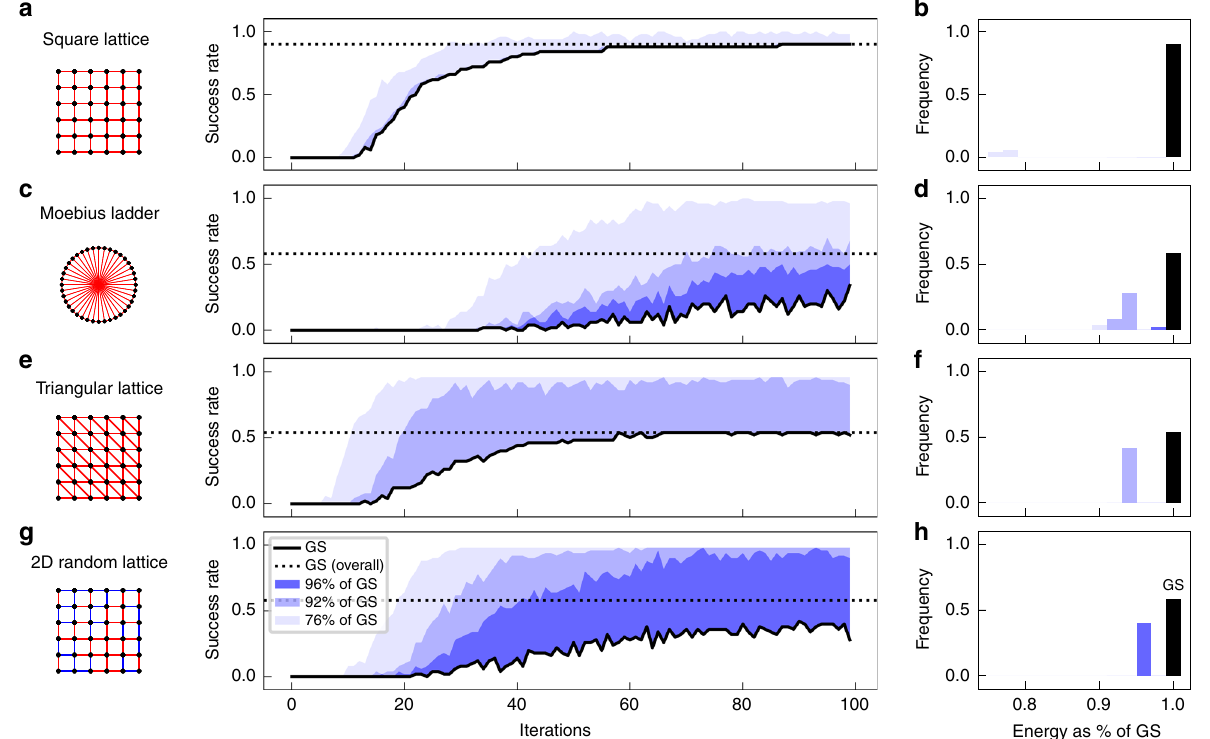
Fig. 4 Time evolution of success rate and energy distribution for various frustrated graphs. Time evolution of the success rate in 50 independent trials to reach the ground state (black line) and 96%, 92%, and 72% of the ground state energy (indicated by shades of blue) as well as the respective histogram of the minimum energies for various graphs with N = 100 spins. Investigated graphs are the square lattice ( a ) and ( b ) (parameters used: α = 0.25, β = 0.29), the Möbius ladder graph ( c ) and ( d ) ( α = 0.07, β = 0.39), the triangular lattice ( e ) and ( f ) ( α = 0.32, β = 0.57), and a 2D random lattice ( g ) and ( h ) ( α = 0.18, β = 0.32). The sketches show the respective coupling scheme, where red connections indicate antiferromagnetic links ( J mn = − 1) and blue connections indicate ferromagnetic interactions ( J mn =